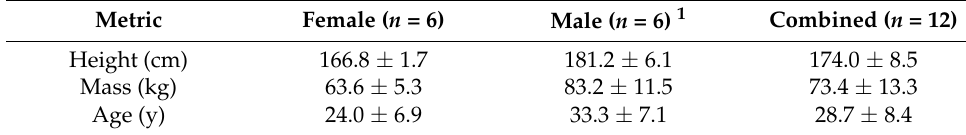
Table 1. Participant information (Mean ± Standard